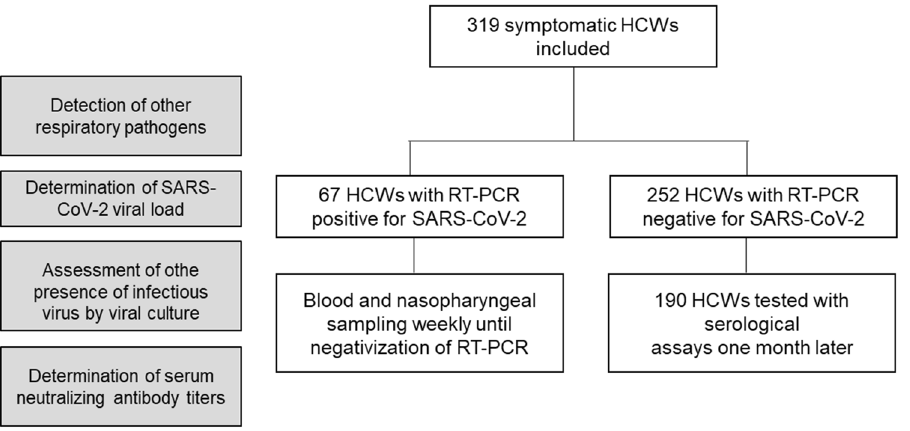
Figure 1. Flow diagram of study population—HCWs, healthcare